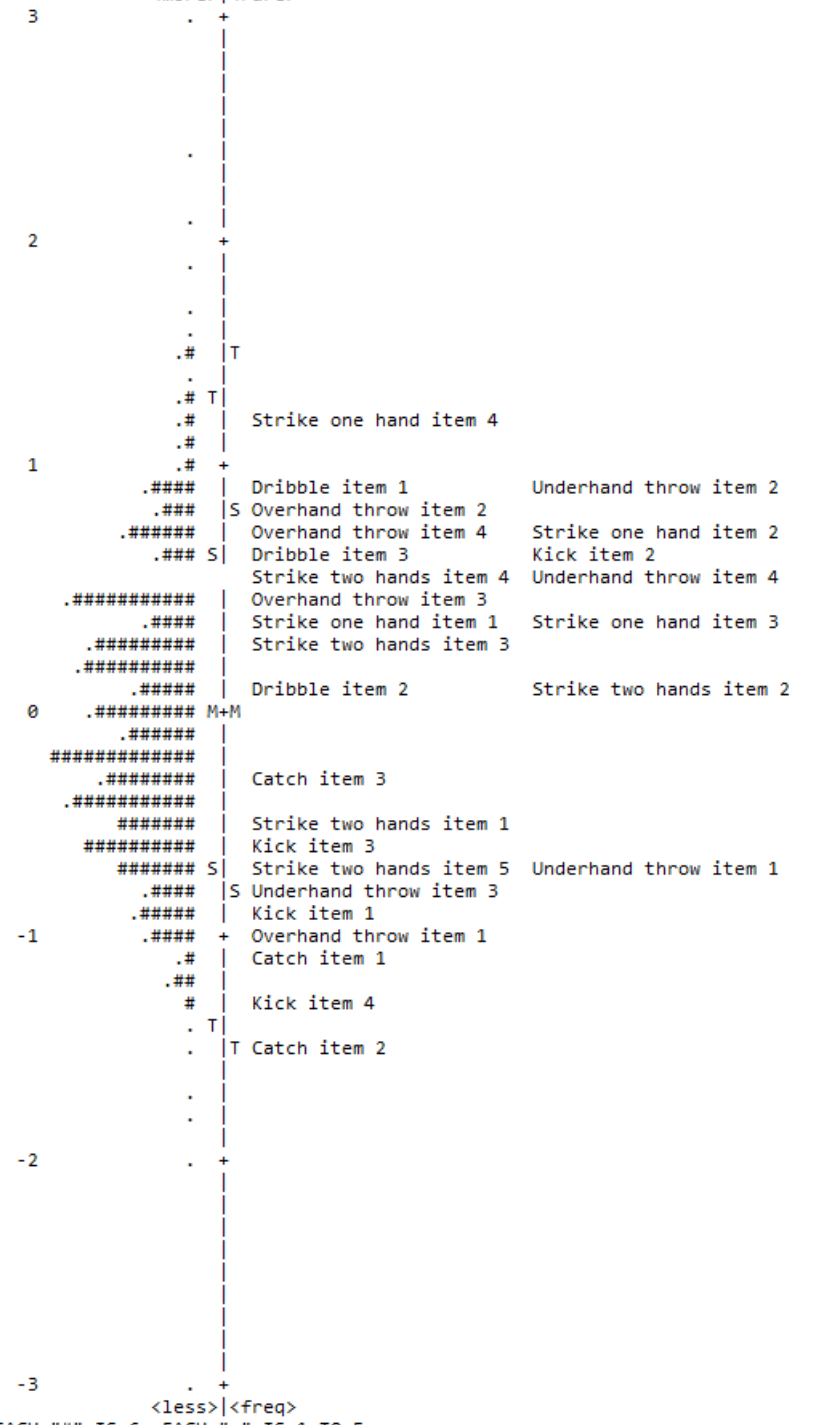
Figure 2. Person-item map: score analysis of the 27 TGMD-3 ball skills items . Note: M = mean of person or item distribution; S = one standard deviation from the person or item mean; T = two standard deviations from the person or item mean; # = several persons or items.